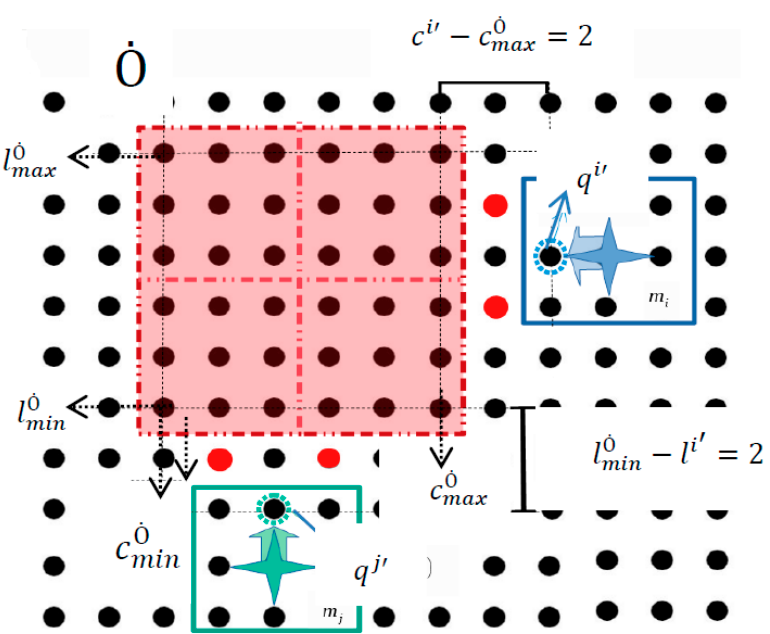
Figure 14. The micropart cannot move to the left as it does not satisfy the static obstacles constraints. Micromachines 2018 , 9 , x FOR PEER REVIEW